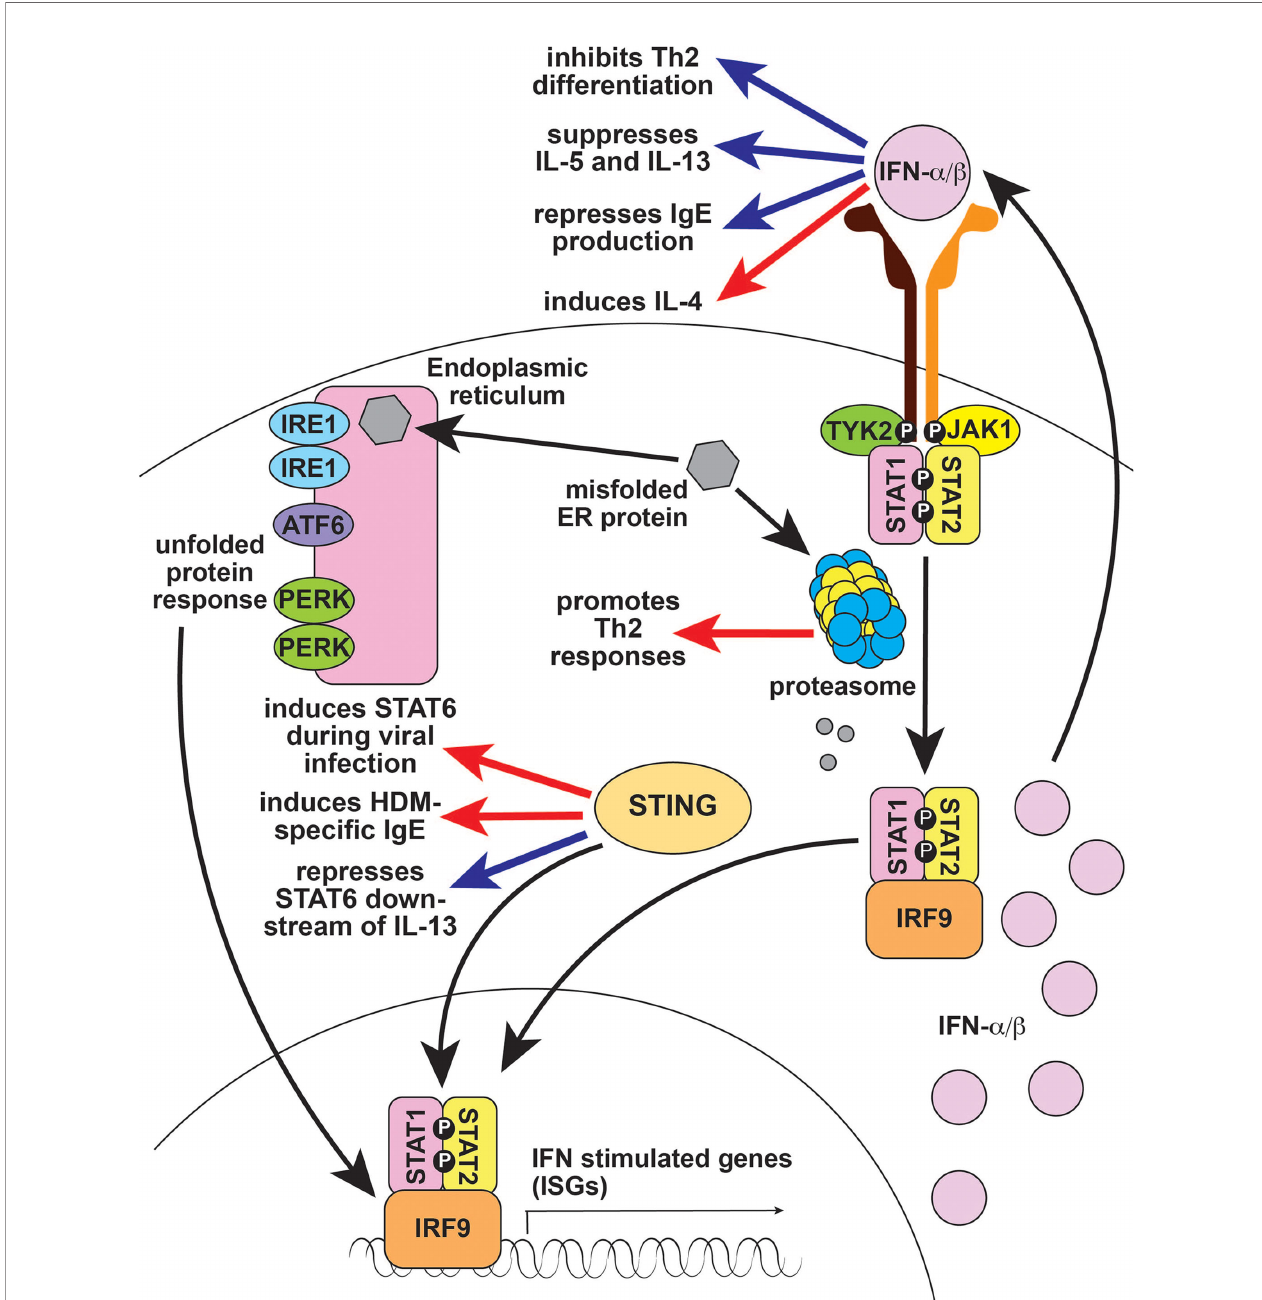
FIGURE 3 | Type 1 interferon signaling in type 2 immune responses. Type 1 IFNs like IFN- a and IFN- b largely suppress type 2 responses (blue arrows), although they are reported to induce IL-4 (red arrow), which can enhance type 2 immunity. The proteasome is important for processing and degrading misfolded endoplasmic reticulum proteins; defects cause unfolded proteins to accumulate, resulting in Type 1 IFN production. The proteasome also regulates antigen processing and presentation which is critical for T cell immunity, including Th2 responses (red arrow). STING is a DNA sensor that activates Type 1 IFN. STING activates STAT6 in response to viral infection and promotes IgE production in response to HDM (red arrow), but also represses IL-13-induced STAT6 activation in subjects with rhinosinusitis (blue arrow). IFN, interferon; ER, endoplasmic reticulum; IRE1, Inositol Requiring Enzyme 1; ATF6, Activating Transcription Factor 6; PERK, PKR-like Endoplasmic Reticulum Kinase; STING, Stimulator of Interferon Genes; TYK2, Tyrosine Kinase 2; JAK1, Janus Kinase 1; STAT1, Signal Transducer and Activator of Transcription 1; IRF9, interferon regulatory factor 9; Th2, T helper 2; IL-4, interleukin 4; IL-5, interleukin 5; IL-13, interleukin 13; IgE, immunoglobulin E, NK, natural killer; HDM, house dust